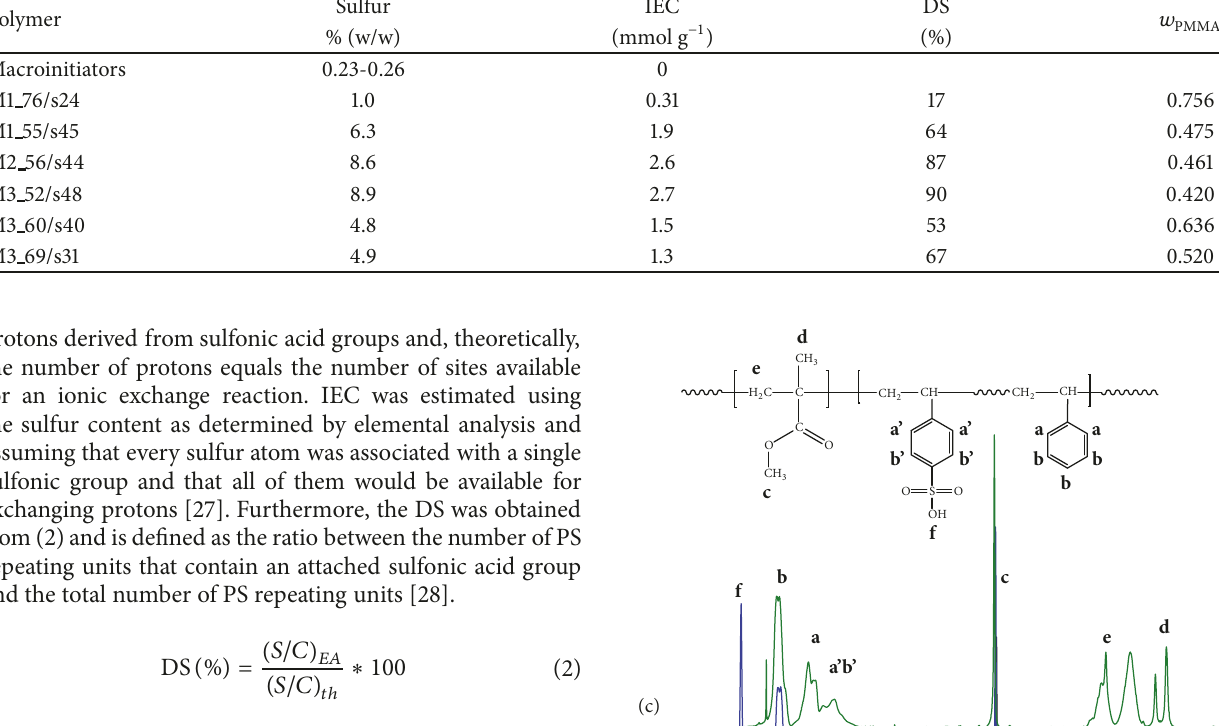
Table 2: Sulfur content, ion-exchange capacities (IEC) and degree of sulfonation (DS) of PMMA- b -sPS BCs. Polymer